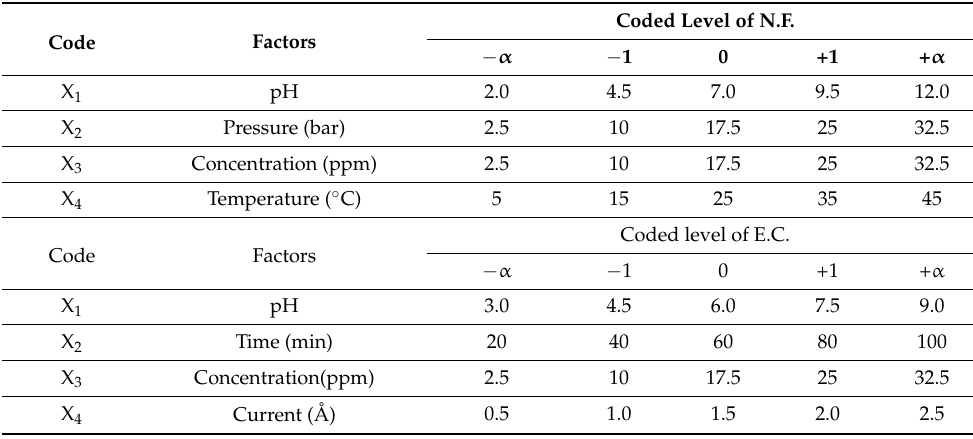
Table 1. Factor and range for design experiments of NF membrane and